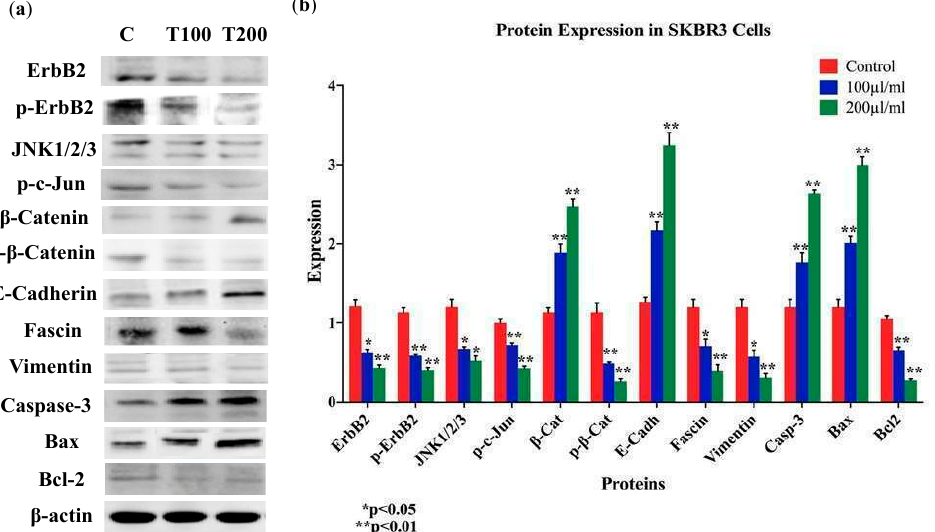
Figure 7. ( a , b ) Protein expression and molecular mechanisms of EA inhibitory actions in SKBR3 cell line. This plant extract induces an overexpression of E-cadherin, β -catenin, and downregulation of vimentin and fascin, while upregulating pro-apoptotic markers (Bax and Caspase-3), in comparison with their control and inhibiting anti-apoptotic markers (Bcl-2). Furthermore, EA plant extract inhibits the phosphorylation of ErbB2 and β -catenin, as well as the expression of JNK1/2/3. β -actin was used as a control for the proteins amount in this assay. Cells were treated with 100 and 200 µL/mL of EA extract for 48 h, as explained in the materials and methods and the results sections. ( a ) Blot image and ( b ) quantification of bands.